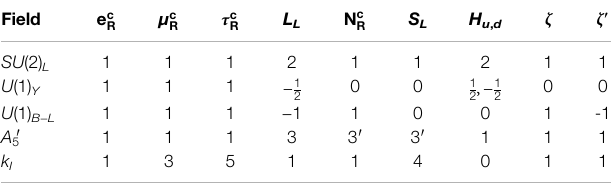
TABLE 1 | Particle spectrum and their charges under the symmetry groups SU ( 2 ) L × U ( 1 ) Y × U ( 1 ) B − L × A 5 ′ , while k I represents the modular